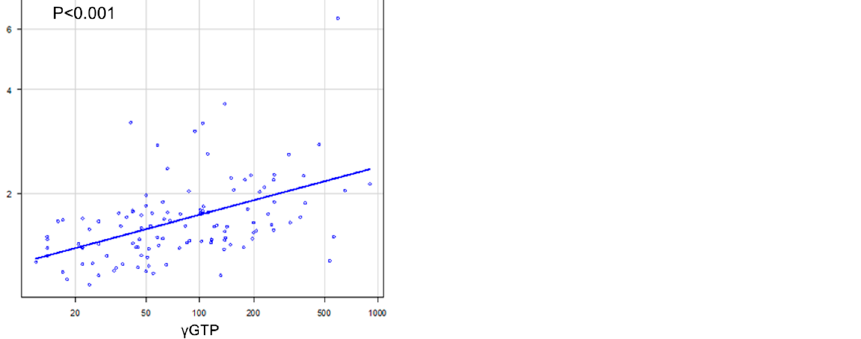
Figure 4. Receiver operating characteristic curves for % of carbohydrate-deficient transferrin and gammaglutamyl transferase alone and combined. 3.3. Prediction Accuracy of %CDT Alone, γ -GTP Alone, and Their Combination for Alcohol Consumption The prediction accuracy of γ -GTP and %CDT alone for the drinking group was 79.2% (74.3% sensitivity and 70.4% specificity) and 79.0% (65.7% sensitivity and 80.2% specific- ity), respectively. The combination of these markers showed a higher accuracy than either of the biomarkers alone (both p < 0.05) (Table 3). The combination of the two markers yielded more sensitivity than either marker alone; however, the differences were not sta- tistically significant. The combination of these markers had a significantly better specific- ity than γ -GTP alone but not %CDT alone ( p = 0.021 and 0.75, respectively). A combined index based on γ -GTP and %CDT measurements had a significantly better prediction per- formance than γ -GTP alone at higher specificity levels.